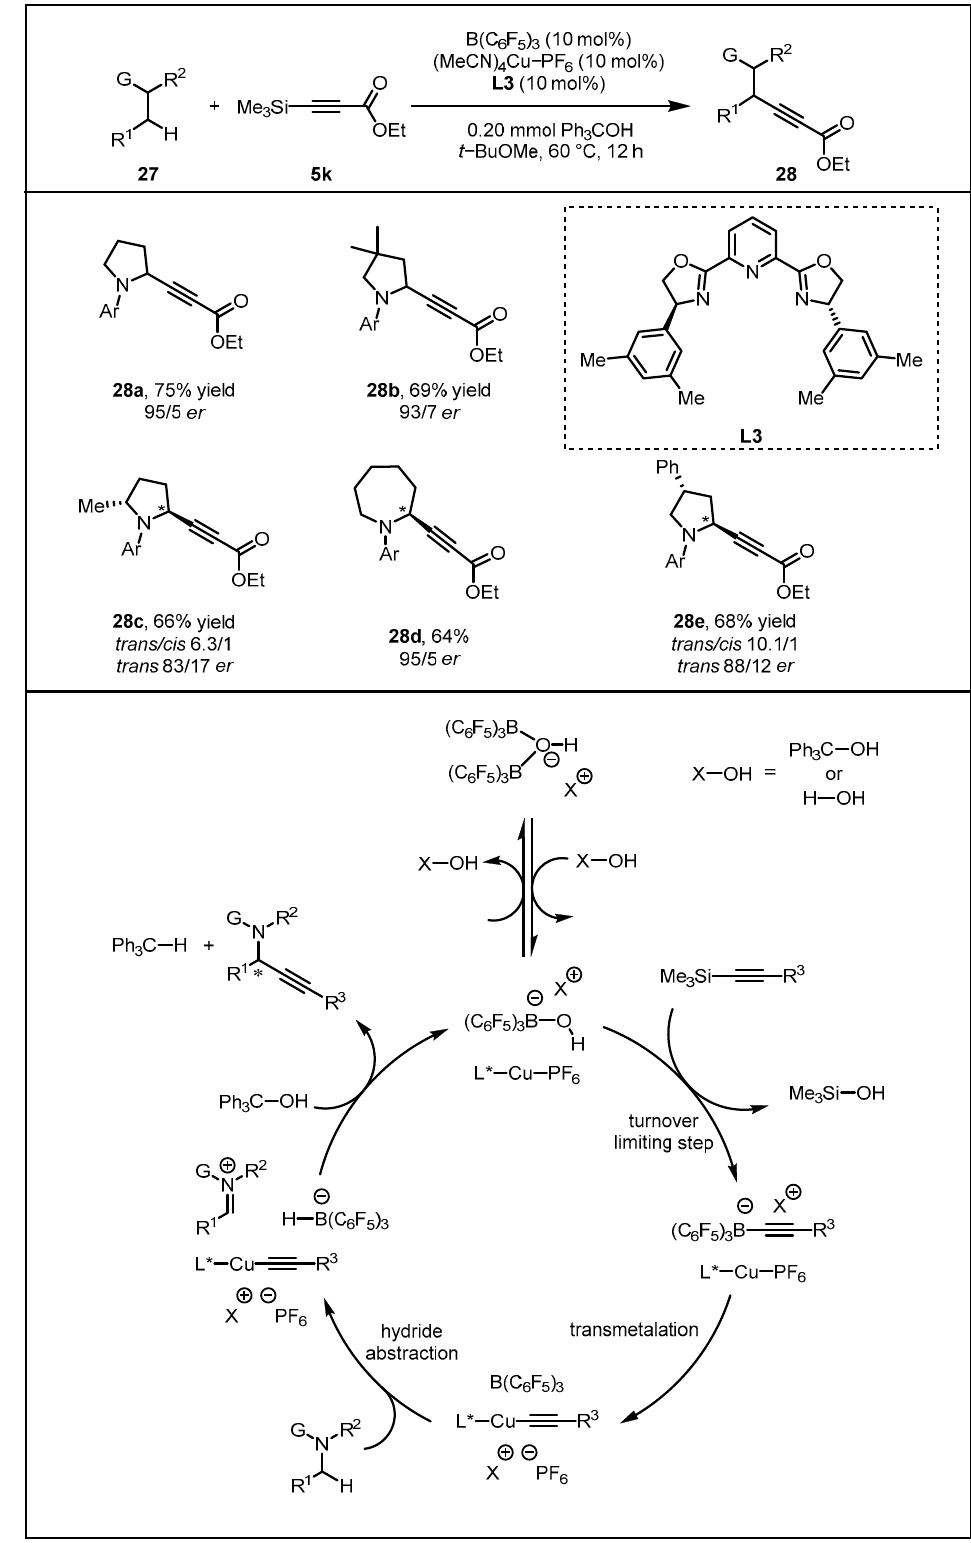
Figure 11. Direct conversion of N-Alkylamines to N-propargylamines promoted by Lewis acid/or- Figure ganocopper catalysis.